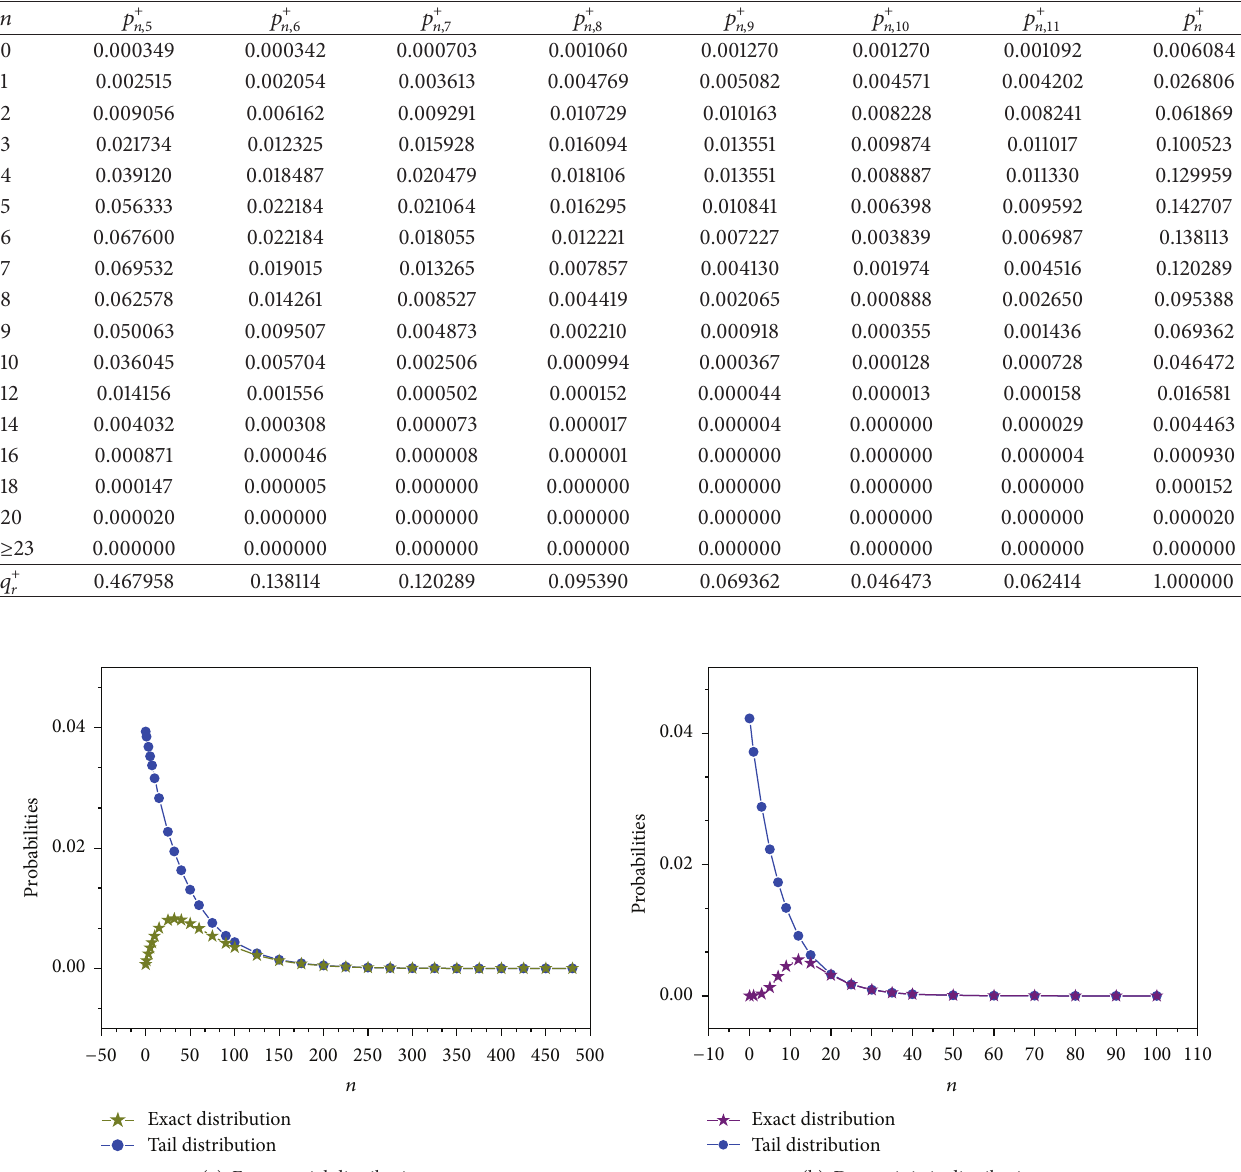
Table 5: Joint distribution of queue and server content at departure epoch ( 𝑝 + 𝑛,𝑟 ) of an 𝑀/𝐺 (5,11) 𝑛 /1 queue with 𝐺 ∼ 𝐷 , 𝜆 = 9 , 𝜇 = 0.25 , = 𝑟𝜇 , and 𝜌 = 0.297521 . 𝜇 𝑟